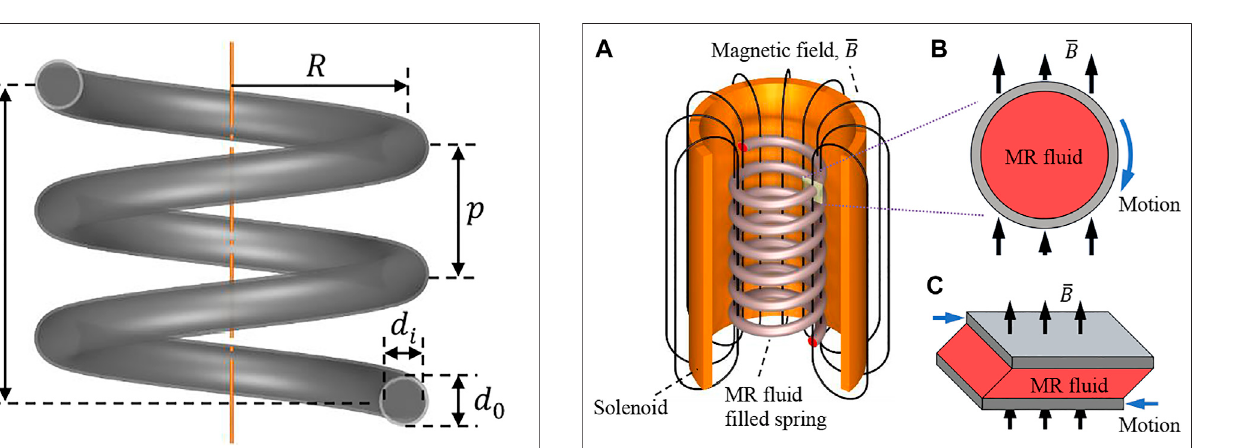
FIGURE 1 | Hollow spring geometry.